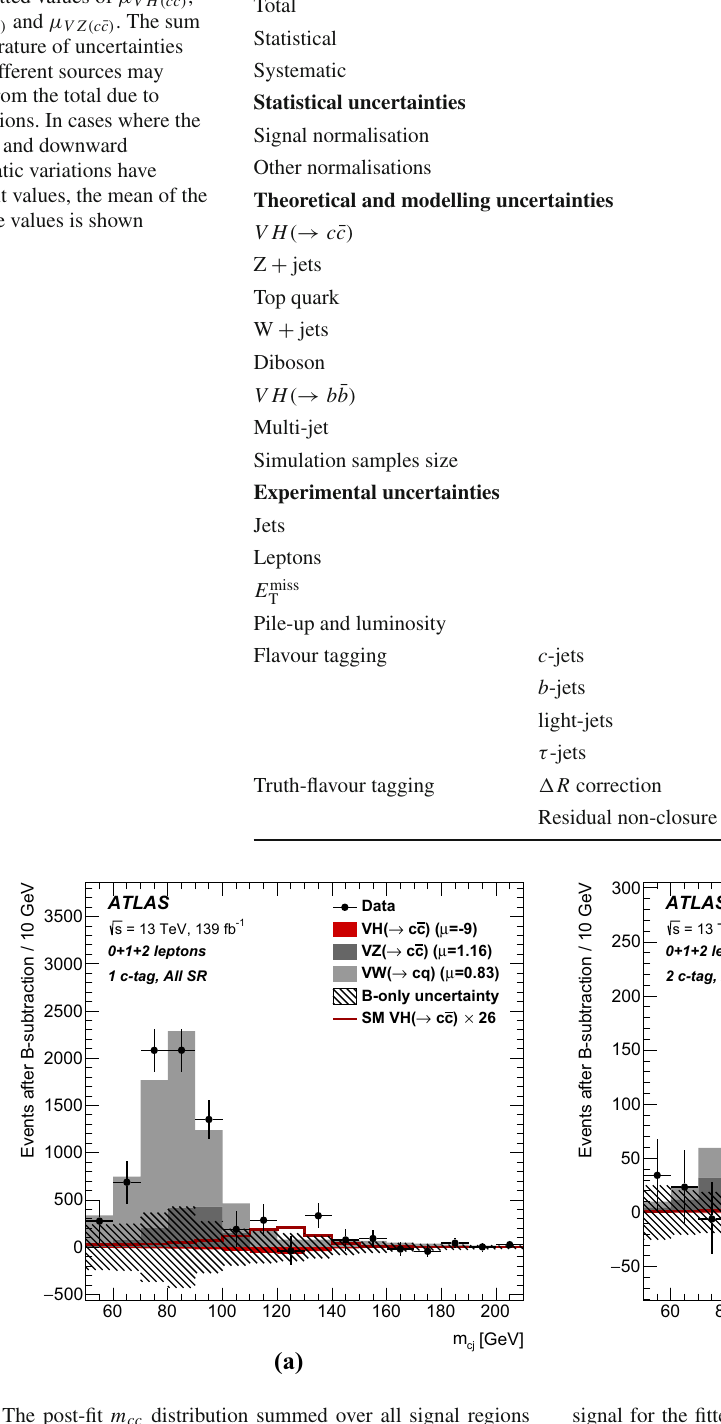
signal for the fitted value of μ VH ( c ¯ c ) = − 9, while the open red his- togram corresponds to the signal expected at the 95% CL upper limit on μ VH ( c ¯ c ) (μ VH ( c ¯ c ) = 26 ) . The hatched band shows the uncertainty of the fitted